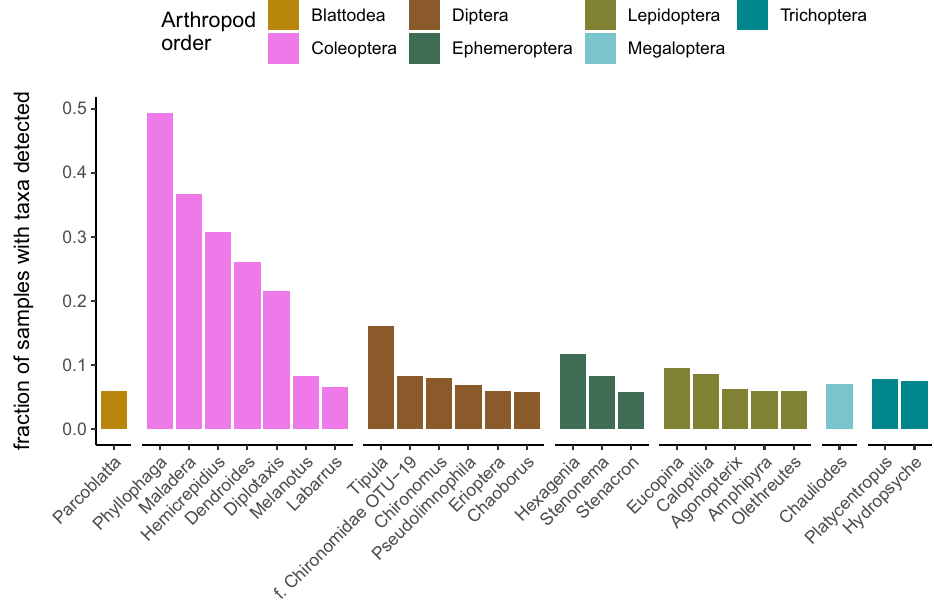
Figure 2. Proportion of samples with commonly detected genus labels organized by arthropod order. Genera shown represent labels present in at least 5% of samples across all New Hampshire sites. One particularly frequent taxon was missing a genus-specific label and is listed by its known family and generic OTU alias (f. Chironomidae